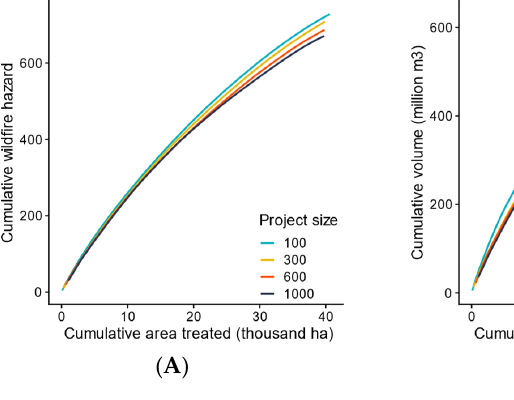
Figure 3. Change in objective attainment with increasing area treated for four different amounts of treated area per project and three scenarios where each of the objectives was optimized: ( A ) wildfire hazard, ( B ) merchantable volume, and ( C ) net revenue.